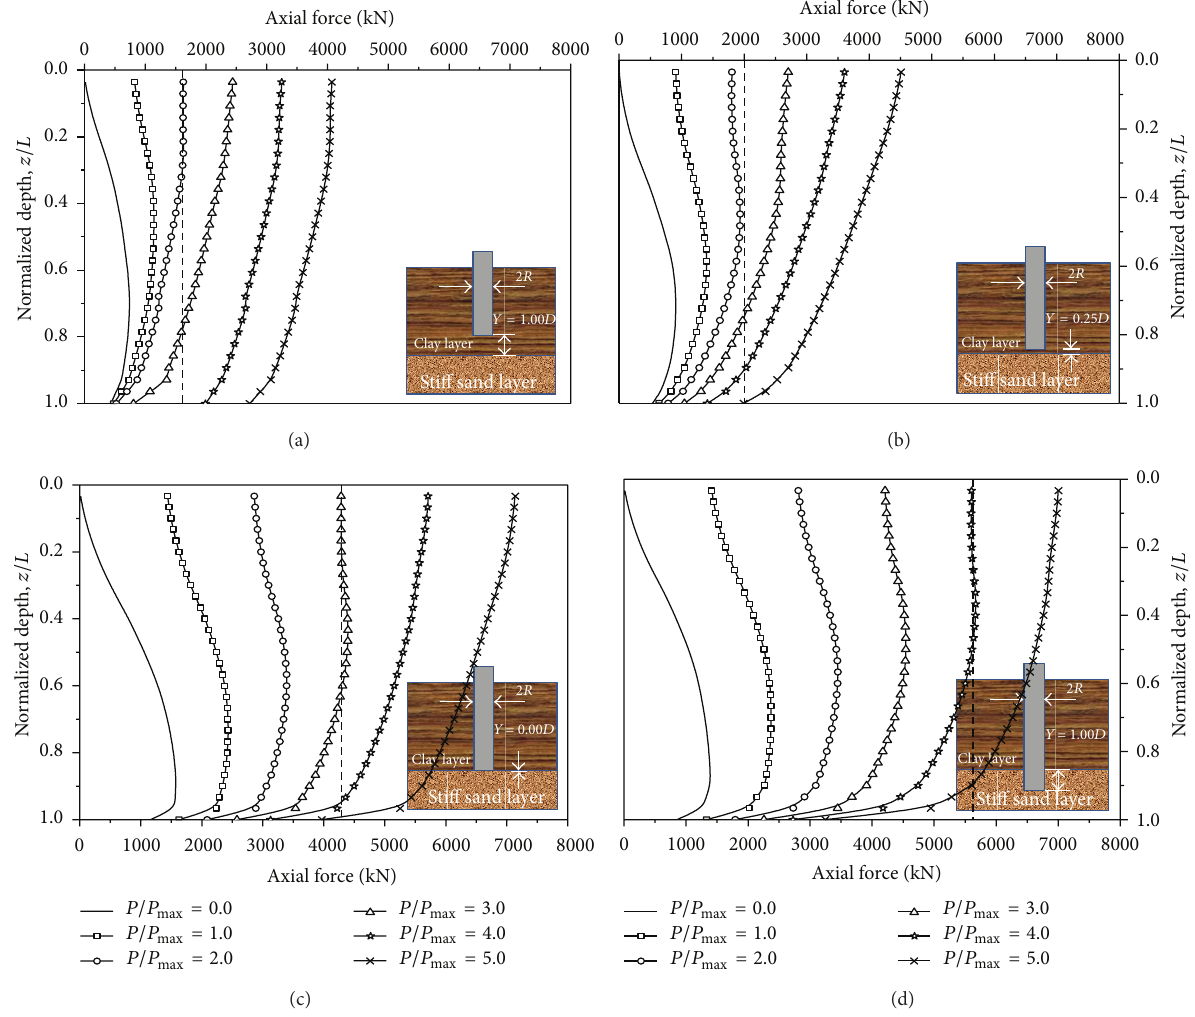
Figure 8: Computed variation of the axial force of a pile with tip location: (a) 𝑌 = 1.00𝐷 , (b) 𝑌 = 0.25𝐷 , (c) 𝑌 = 0.00𝐷 , and (d) 𝑌 = −1.00𝐷